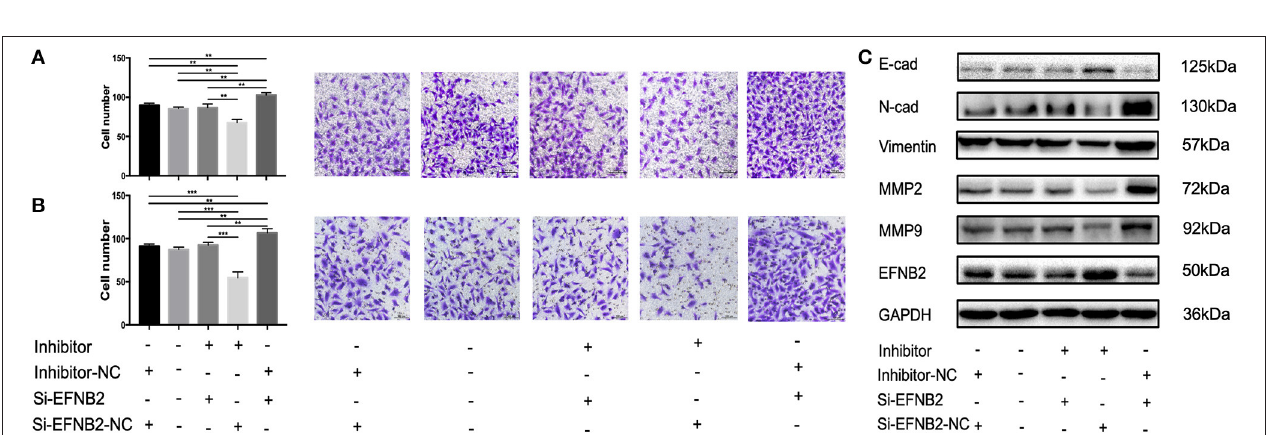
FIGURE 4 | EFNB2 downregulation promotes the migration and invasion of HTR-8/SVneo cells. (A) EFNB2 mRNA expression examined after transfection of HTR-8/SVneo cells with siRNA for EFNB2. (B) Levels of EFNB2 and EMT-related proteins detected after 48-h transfection. (C,D) Transwell migration and invasion assays showing higher numbers of migrated and invaded cells in the si-EFNB2 group than in the NC group ( × 200). All data are presented as the mean ± standard deviation. EFNB2, Ephrin-B2; Si, siRNA; NC, negative control; EMT, epithelial-mesenchymal transition. * P < 0.05, ** P < 0.01, *** P < 0.001, and **** P < 0.0001.